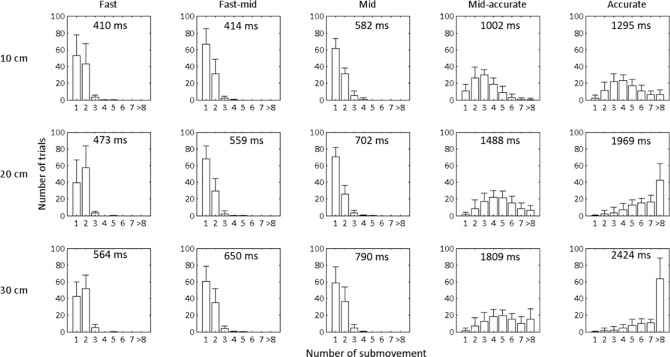
The average number of trials as a function of number of submovements (1 = only primary movement, 2 = primary movement with secondary submovement etc.) in a trial for different movement space-time conditions.Top row indicates 10 cm, middle row shows 20 cm, and bottom row is 30 cm movement amplitude. The error bars represent the between-participant standard deviation. The upper middle of each graph shows the mean movement time for each space-time condition.